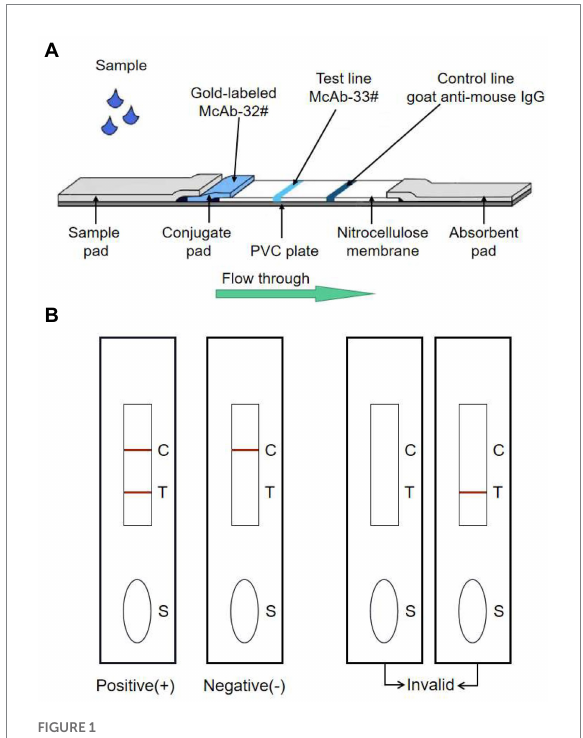
FIGURE 1 The schematic representation of the GICA strip. (A) The strip included three pads (sample, conjugate and absorbent), an NC membrane, and a PVC plate. The conjugate pad contained the dried gold-labeled mAb-32 # , which provided an easily visible red color. There were two lines on the NC membrane: the control line and the test line. The test line contained mAb-33 # . The control line contained the goat anti-mouse IgG antibody. (B) The detecting principle of the GICA strip.